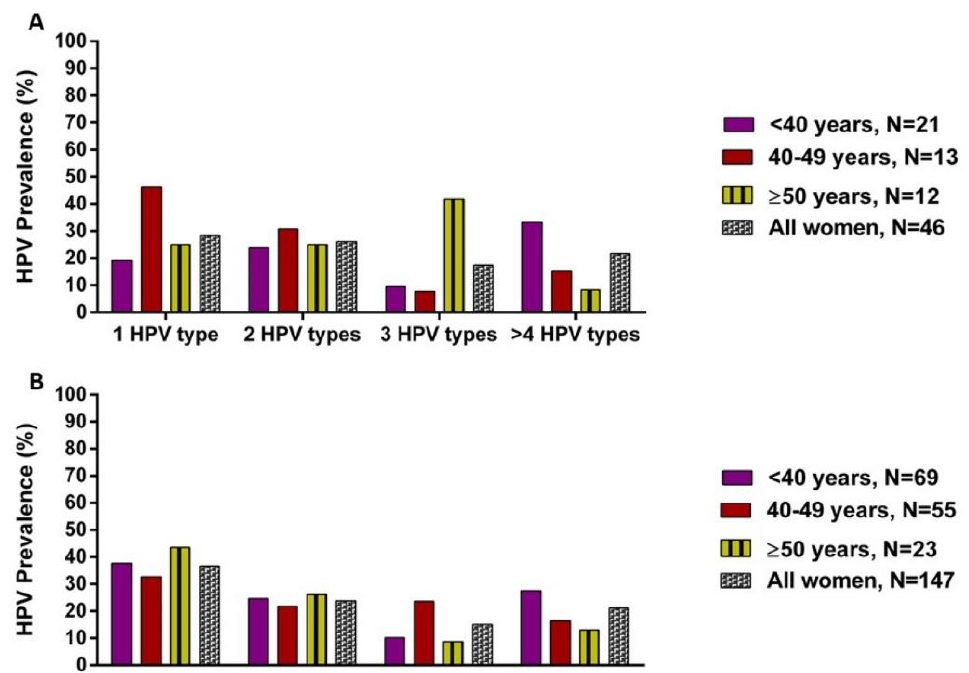
Figure 2. Distribution of single and multiple HPV types according to age in women with CIN2 ( A ) and CIN3 ( B ).